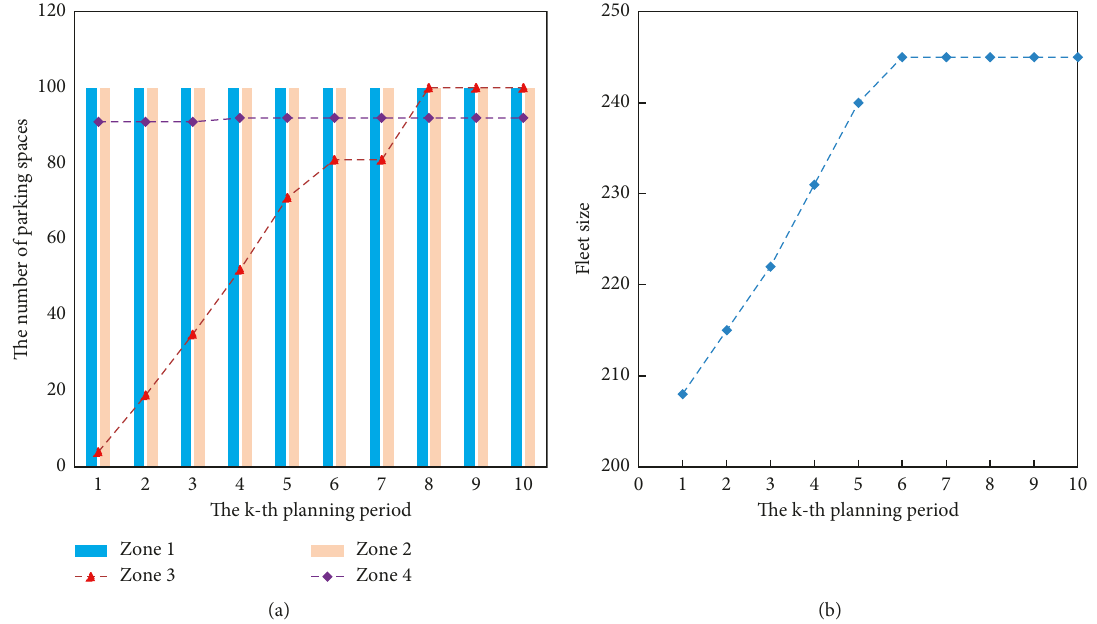
Figure 9: The number of parking spaces at each zone (a) and fleet size (b) at the beginning of k-th